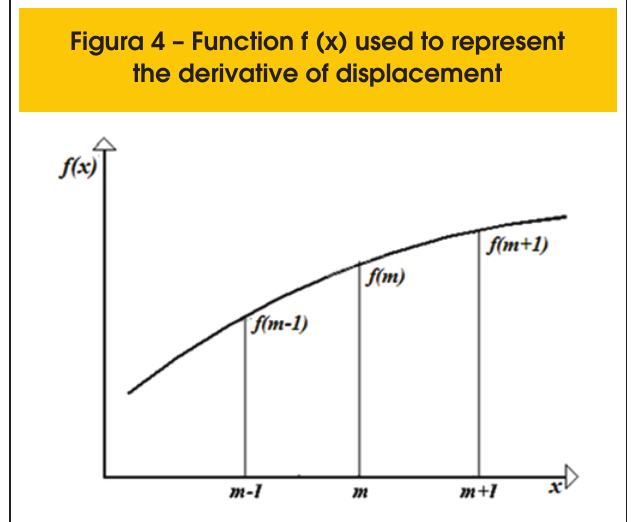
Figure 5 – Finite difference discretization of plate: nine sections of